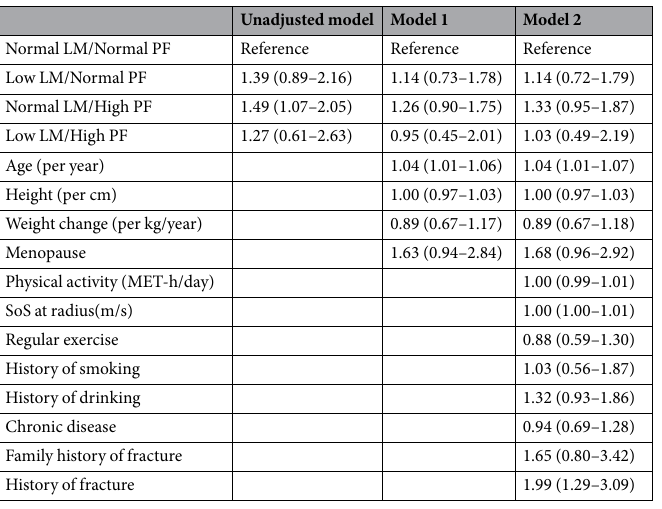
Table 5. Cox proportional hazard models for fragility fractures in women according to body composition. Data are shown as HRs (95% CI). LM, lean mass; PF, percentage body fat; Model 1, adjusted for age, height, weight change and menopausal status; Model 2, additionally adjusted for physical activity, speed of sound at radius, regular exercise, history of smoking, history of drinking, chronic diseases, family history of fracture, and history of